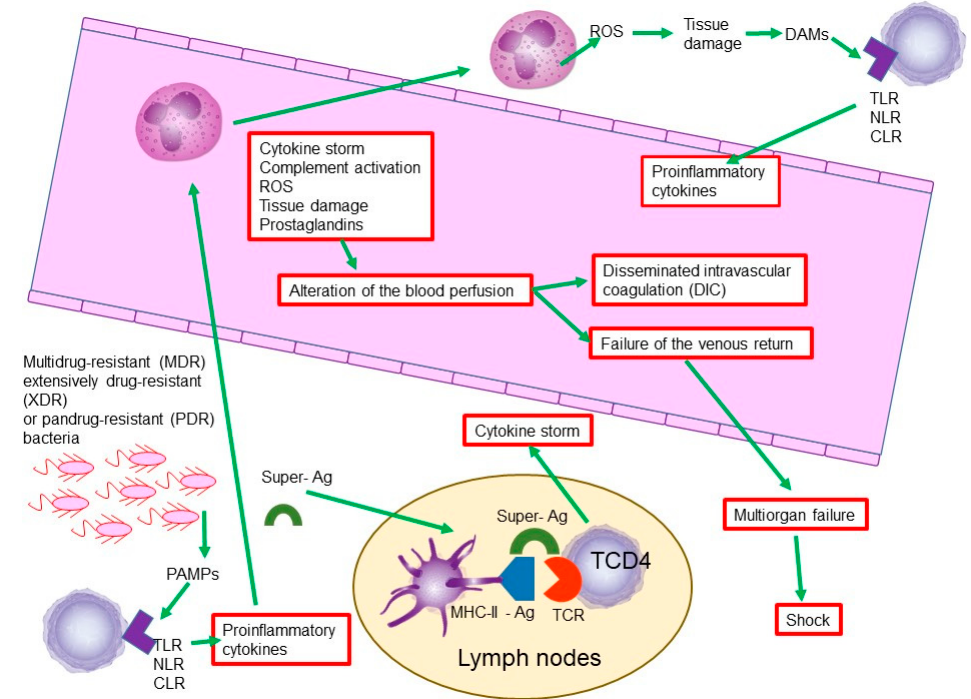
Figure 4. A brief look at the molecular and cellular mechanisms involved in the pathophysiology of sepsis. CLR: C-type lectin receptor; DAMP: damage-associated molecular pattern; MHC-II: histocompatibility complex class II; NLR: NOD-like receptor; PAMP: pathogen-associated molecular pattern; ROS: reactive oxygen species; TCR: T-cell receptor; TLR: Toll-like receptor.